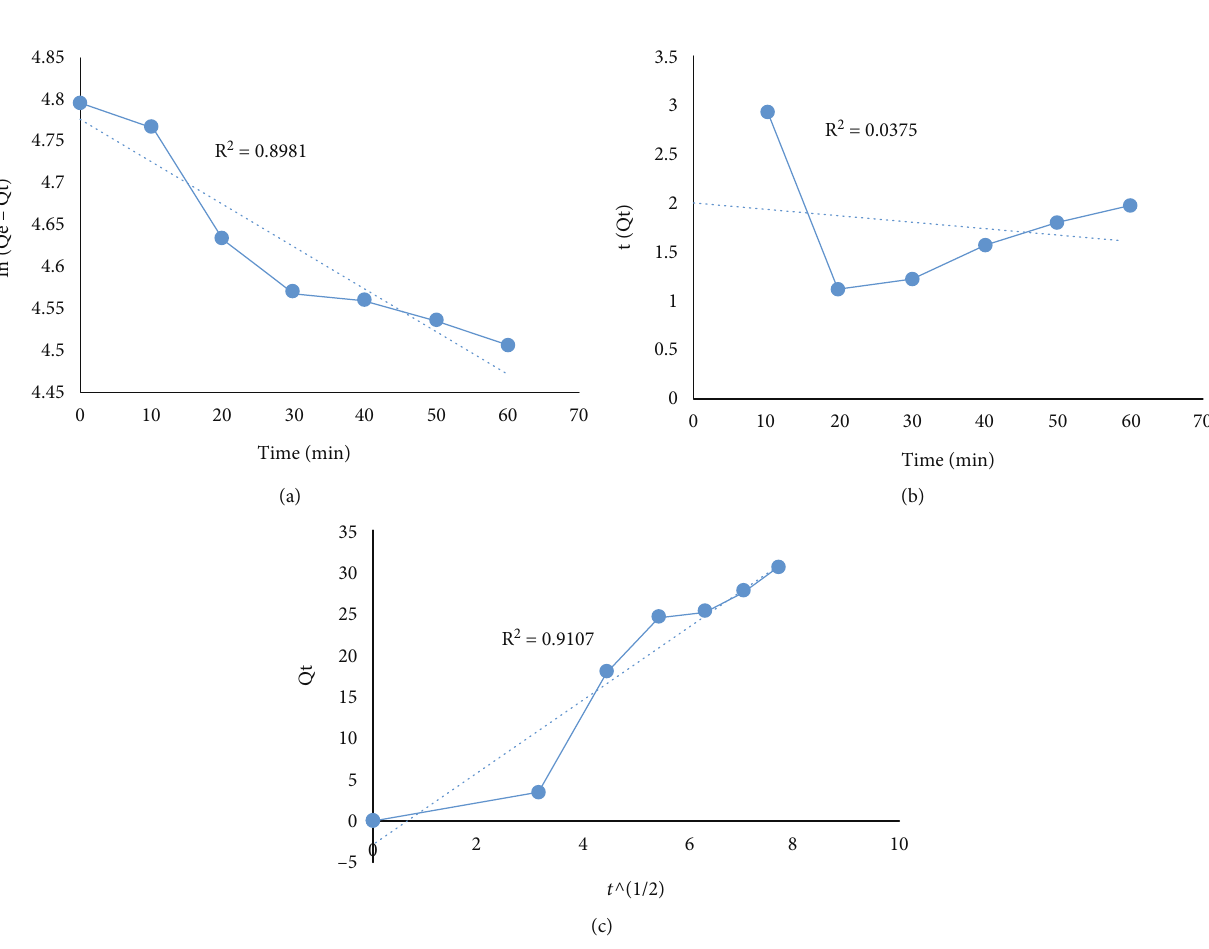
Figure 11: (a) Pseudo- fi rst-order, (b) pseudo-second-order, and (c) intraparticle di ff usion study of methyl red removal by RPP. Table 4: Kinetic parameters for methyl red removal by rose petal